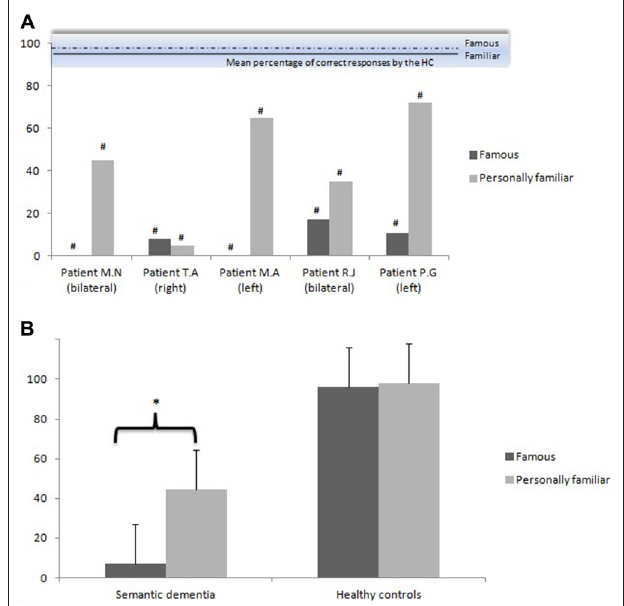
FIGURE 2 | Mean percentage of correct responses (and standard errors) on the identification free-recall task in both experimental conditions (personally familiar names vs. famous names) by the semantic dementia group (displayed by each patient in (A), at the group level in (B) and the healthy controls (HC) (B) Bilateral, right, left: laterality of the temporal atrophy . # Significant ( p < 0.05) in comparison to the healthy controls (inter-group analyses). ∗ Significant ( p < 0.05) in comparison to the other experimental condition (intra-group analyses). Inter-Group